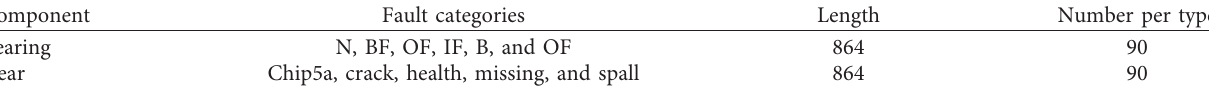
Table 4: Description of the testing